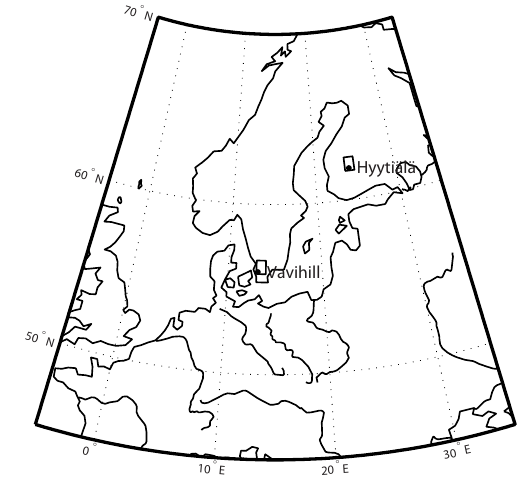
Figure 1. Map showing the locations of the ground-based in situ measurement stations and the surrounding areas used for the satel- lite retrieved cloud